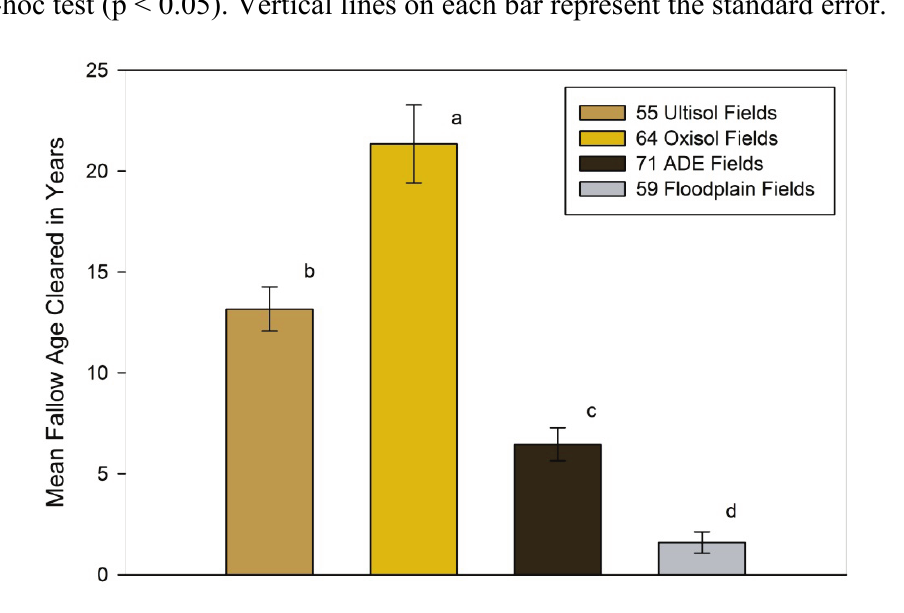
Figure 5. ANOVA comparing mean fallow age cleared in years in four types of soil along the middle Madeira River. Letters indicate significantly different means based on Tukey’s post-hoc test (p < 0.05). Vertical lines on each bar represent the standard